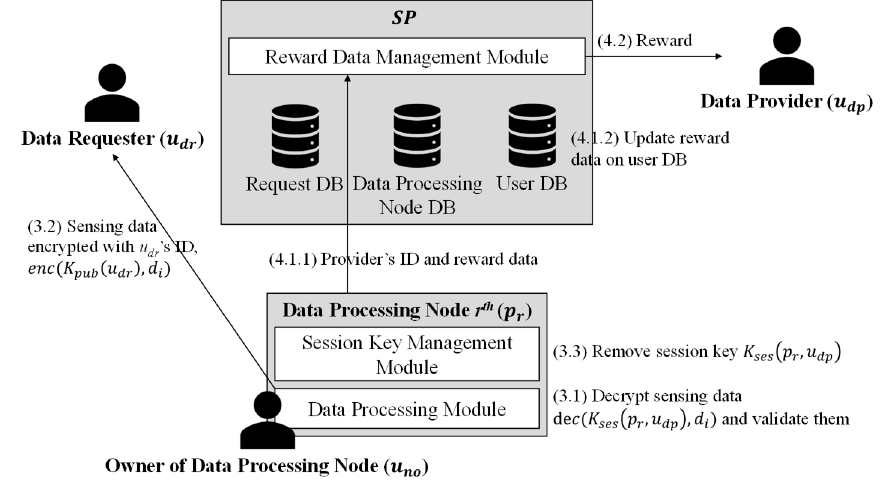
Figure 7. Flow of sensing data processing and reward payment.